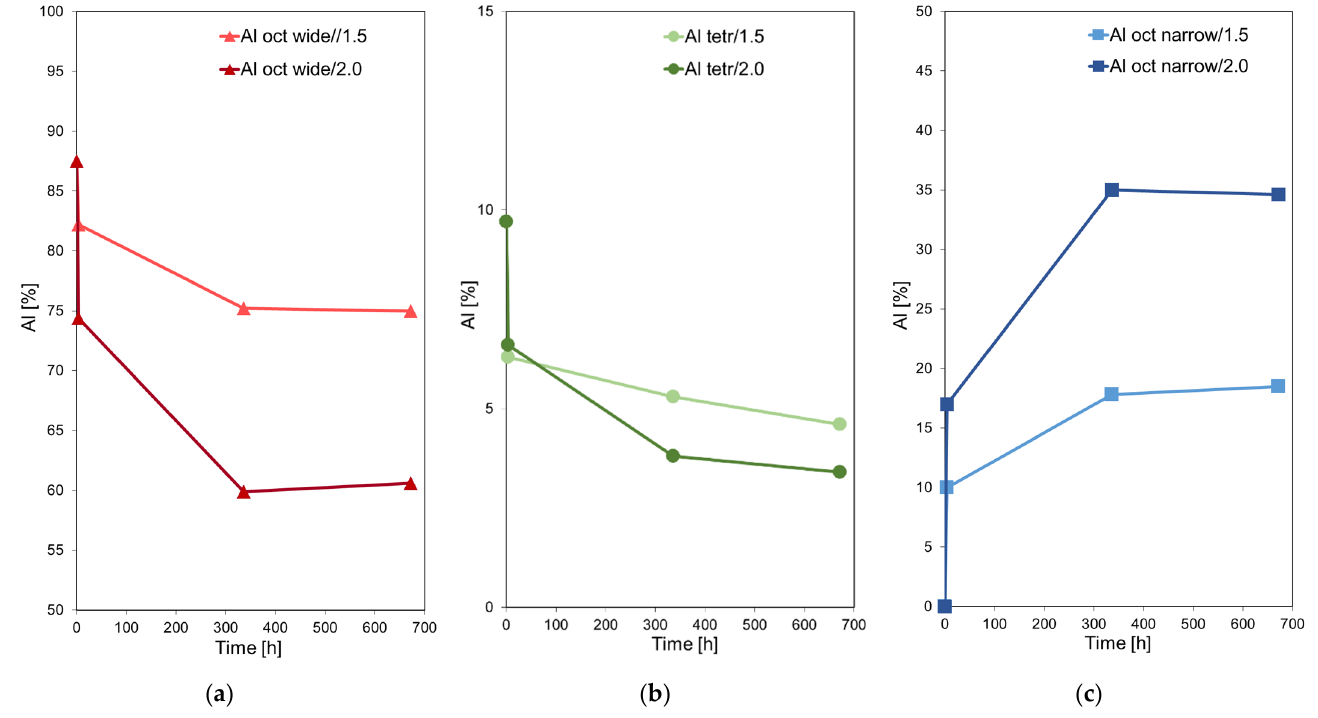
Figure 5. Evolution with time of aging of various montmorillonite-related Al species detected by 27 Al MAS NMR: ( a ) wide component of the octahedral Al corresponding to lattice Al; ( b ) tetrahedral Al component corresponding to Al substituting for Si in the silica sheet; ( c ) narrow component of the octahedral Al, corresponding to Al extracted from the layers.